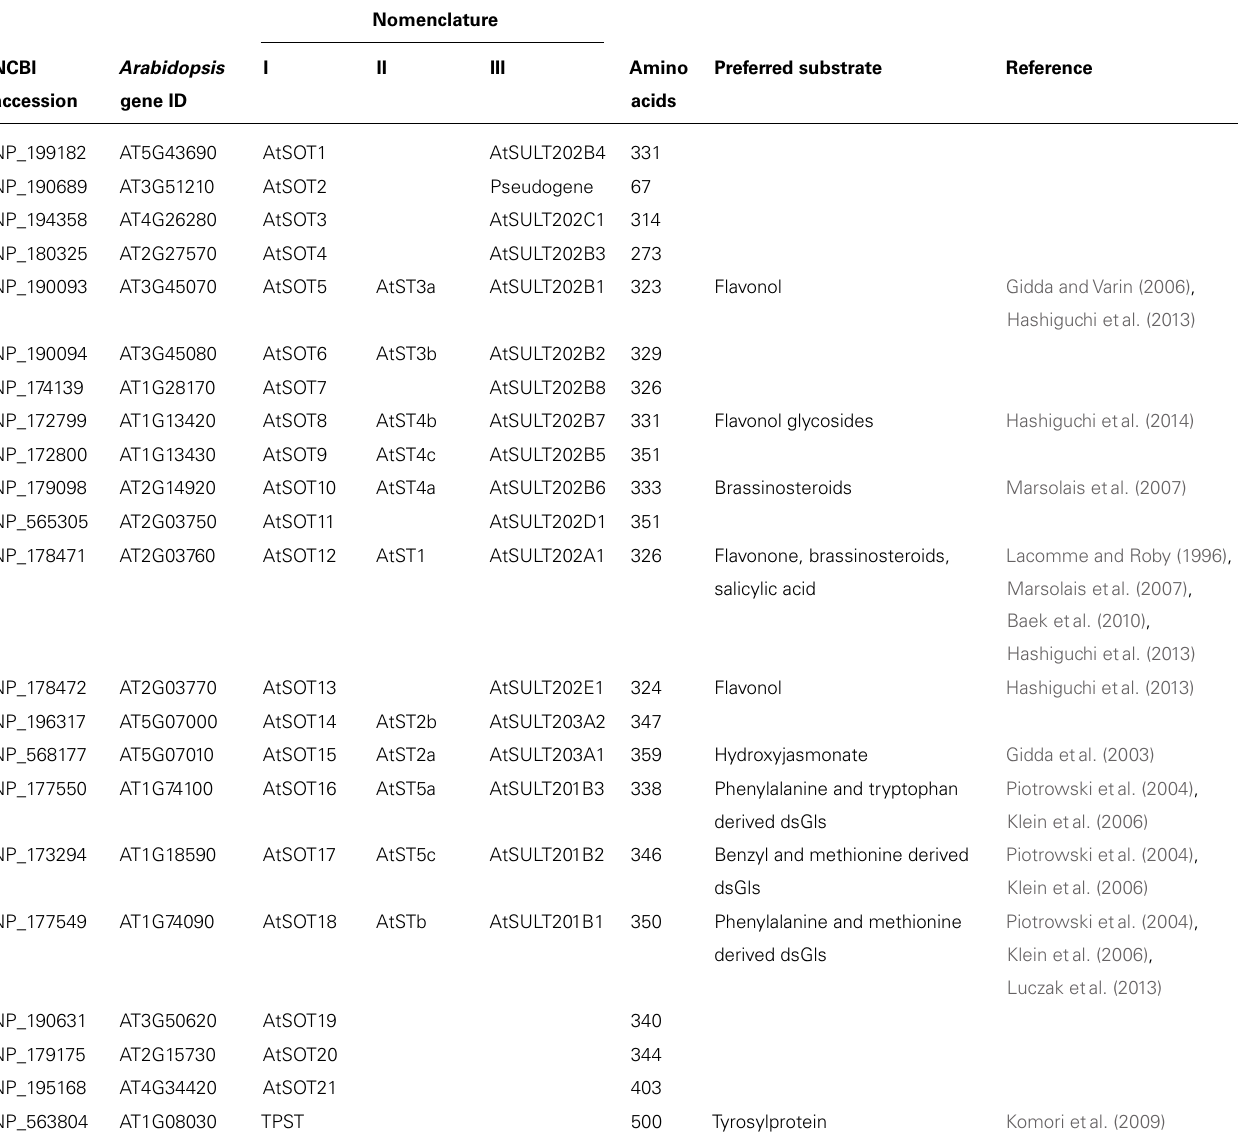
FIGURE 2 | Conserved regions I to IV of plant SOTs. Regions are shown as boxes, with size and position in the protein relative to the average size of SOTs from Arabidopsis thaliana . Functional amino acids were obtained from structural analyses of mouse SOTs as described above. The PAPS